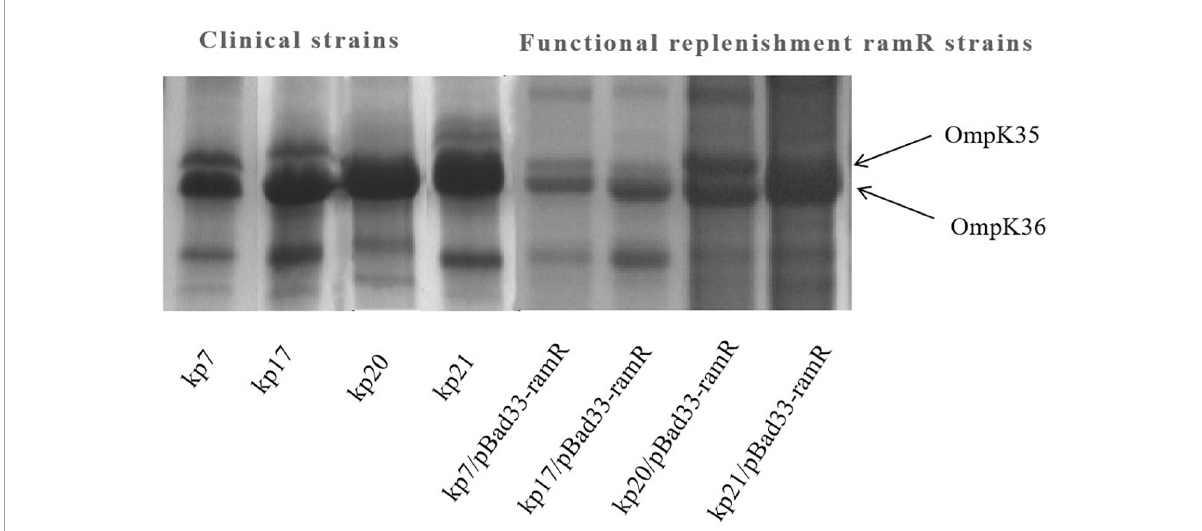
FIGURE3 Outer membrane protein (OMP) profiles of Klebsiella pneumoniae strains on a 12% sodium dodecyl sulphate-polyacrylamide gel. Lane 1–4 shows the OMPs of strains kp7, kp17, kp20, and kp21. Lane 4–8 shows the OMPs of strains kp7, kp17, kp20, and kp21 functionally supplemented with